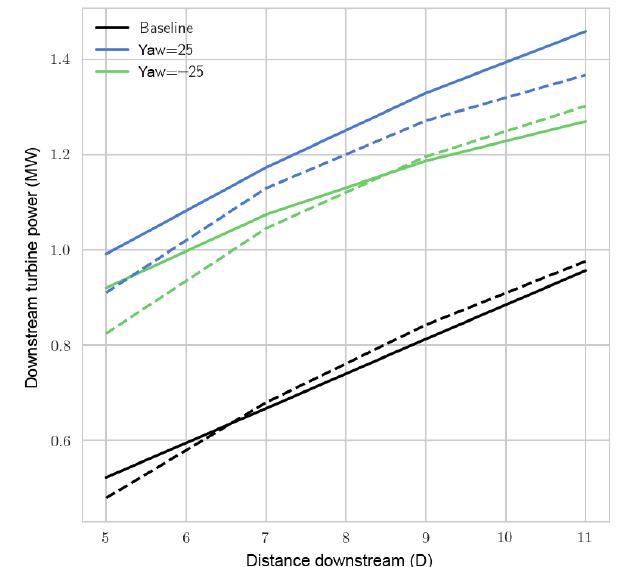
Figure 2. Power output in SOWFA (solid) and FLORIS (dashed) for a hypothetical turbine directly downstream of a baseline or yawed turbine at different